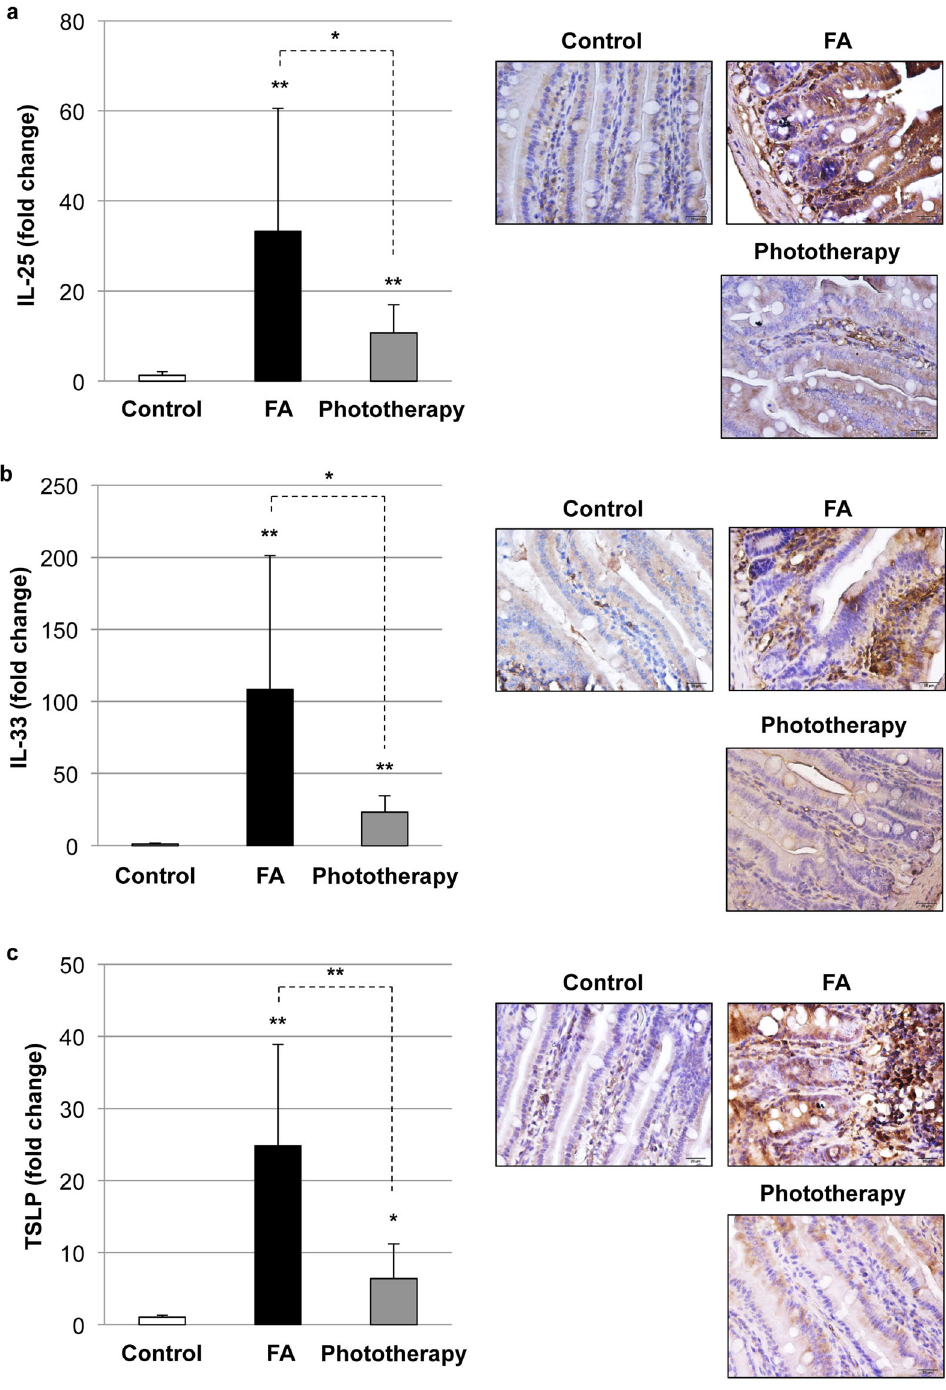
Fig. 3 Impact of phototherapy on food allergy (FA)-associated pro-Th2 cytokine expression. Intestinal levels of IL-25 ( a ), IL-33 ( b ), and thymic stromal lymphopoietin (TSLP) ( c ) were evaluated by quantitative real-time PCR and immunohistochemistry (IHC). Left: values are presented as the mean ± SD of at least eight individuals in each group. *, **, P < 0.05 and 0.01 vs. the control or phototherapy group, respectively (Student ’ s t test). The pictures at ×400 magni fi cation are representative of at least six individuals in each group. Scale bar: 20 μ